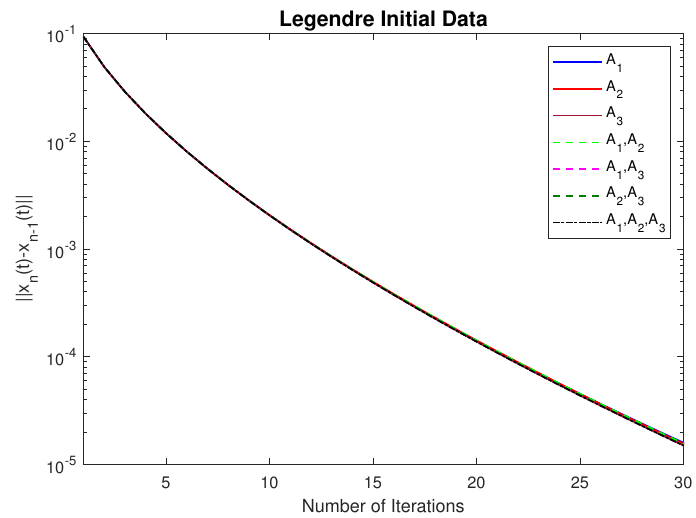
Figure 6. The error plotting (cid:107) x n ( t ) − x n − 1 ( t ) (cid:107) for choice 3 in Example